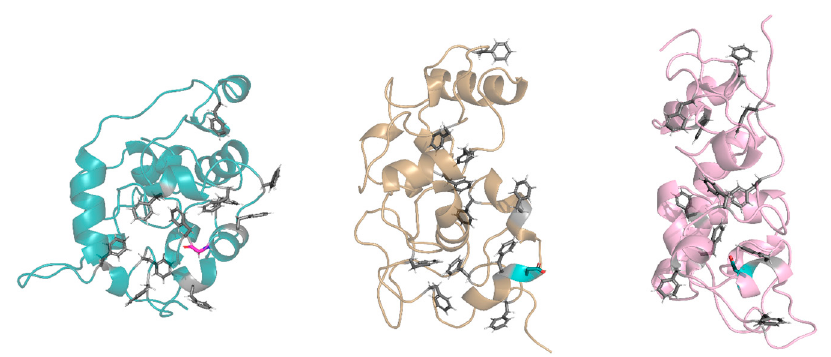
Figure 7. Exposed and buried conformations of G28D in comparison with wild type. On the left, a conformation of the wild type (azure ribbon), in the centers, a conformation of the G28D with the D28 in the exposed conformation (orange ribbon), and on the right, a conformation of the G28D with the D28 in the buried conformation (pink ribbon). Phenylalanines of the FG motifs are shown in grey sticks, while the G28 and the D28 are in purple and in cyan stick, respectively.